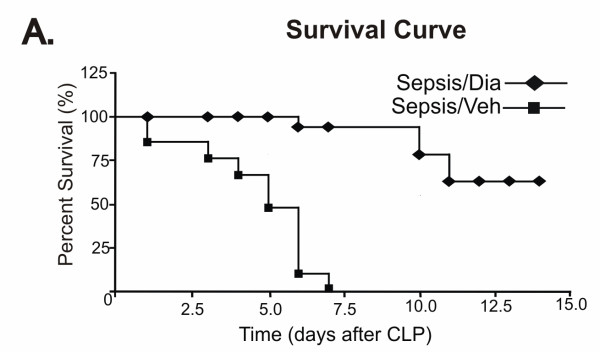
Effect of diacerhein on survival in CLP sepsis model. (A) Male Wistar rats, 8 weeks old, were given vehicle (Sepsis/Veh (■), n = 15) or diacerhein, 100 mg/kg (Sepsis/Dia (◆), n = 15), 3 hours and once a day after CLP. Survival of the rats was monitored at intervals of 12 hours for 15 days. The overall difference in survival rate between the groups with and without diacerhein was significant (P < 0.05).